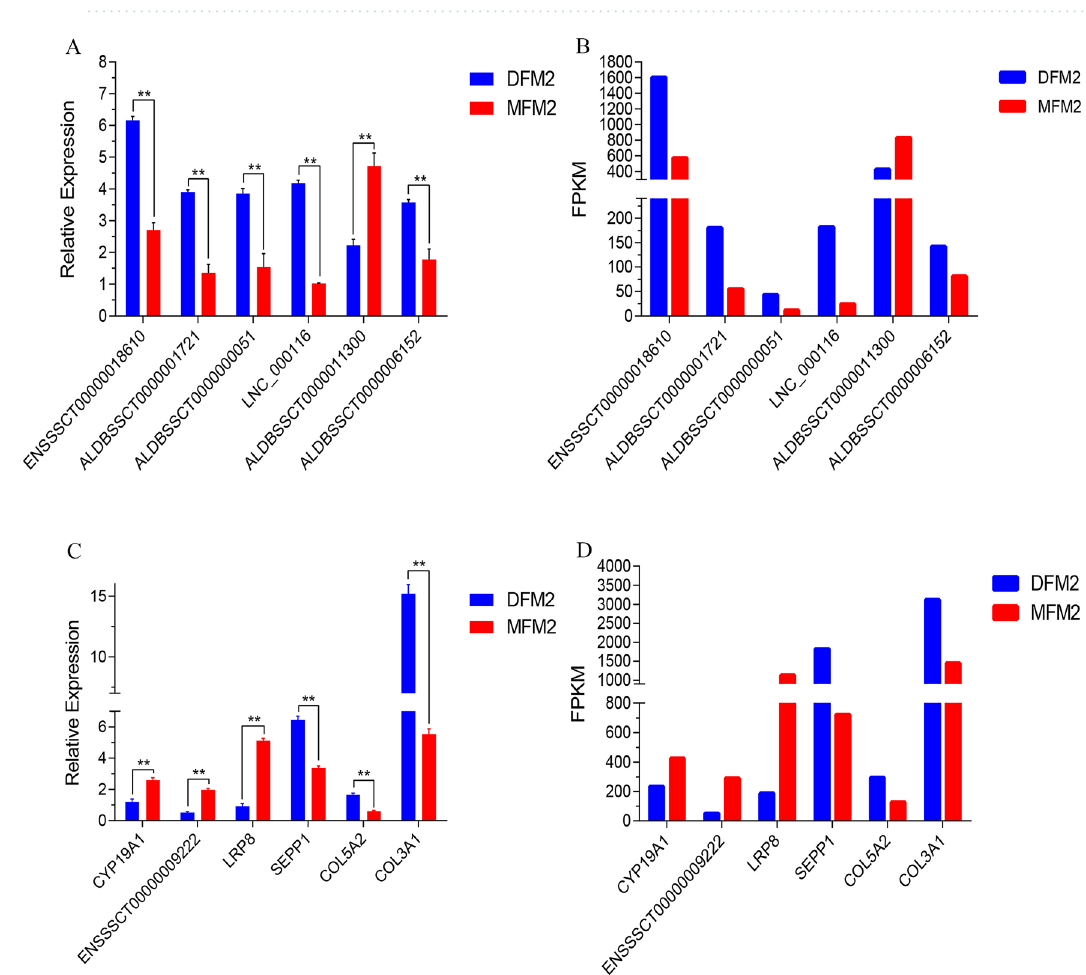
Figure 3. Validation of the expression levels of lncRNAs and mRNAs. The expression of transcripts was normalized by GAPDH. The results were expressed as mean ± SE, *represents P < 0.05, **represents P <